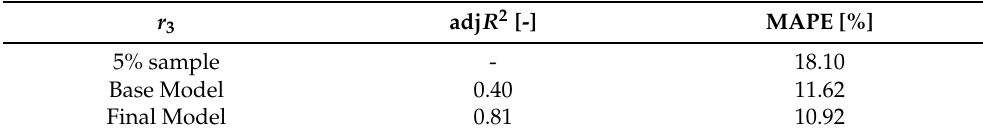
Figure 9. 10 min WMA travel times estimates of the baseline model, estimation model, compared to the 5% data sample and the ground-truth on r 3 . Table 3. Adjusted R-square values of the model performance on the training data. MAPE denotes the comparison of travel times estimates (baseline model and estimation model), and 5% sample of r 3